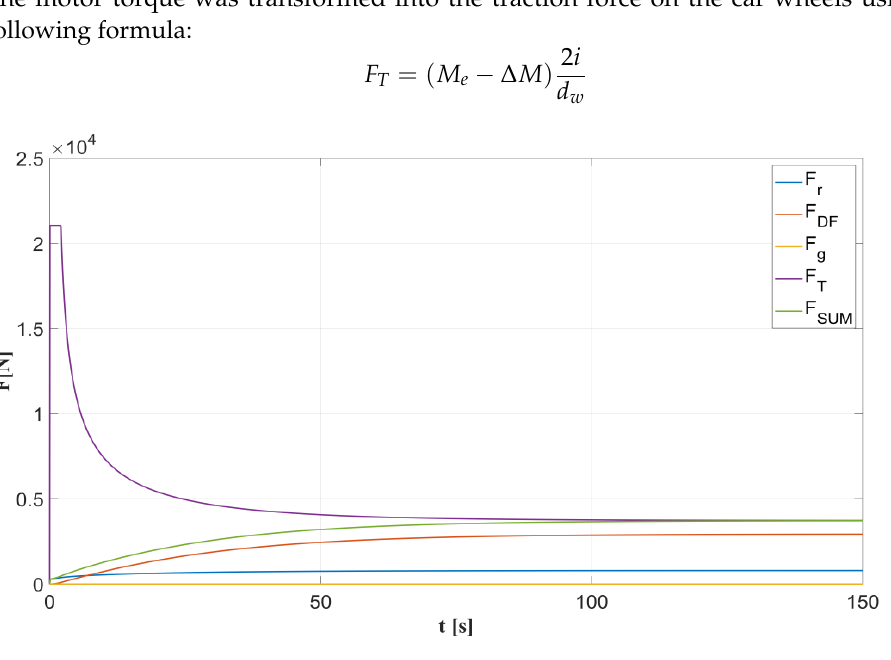
Figure 10. Forces acting on vehicle obtained from simulation results, where 𝐹 𝑇 is the traction force on the car wheels.